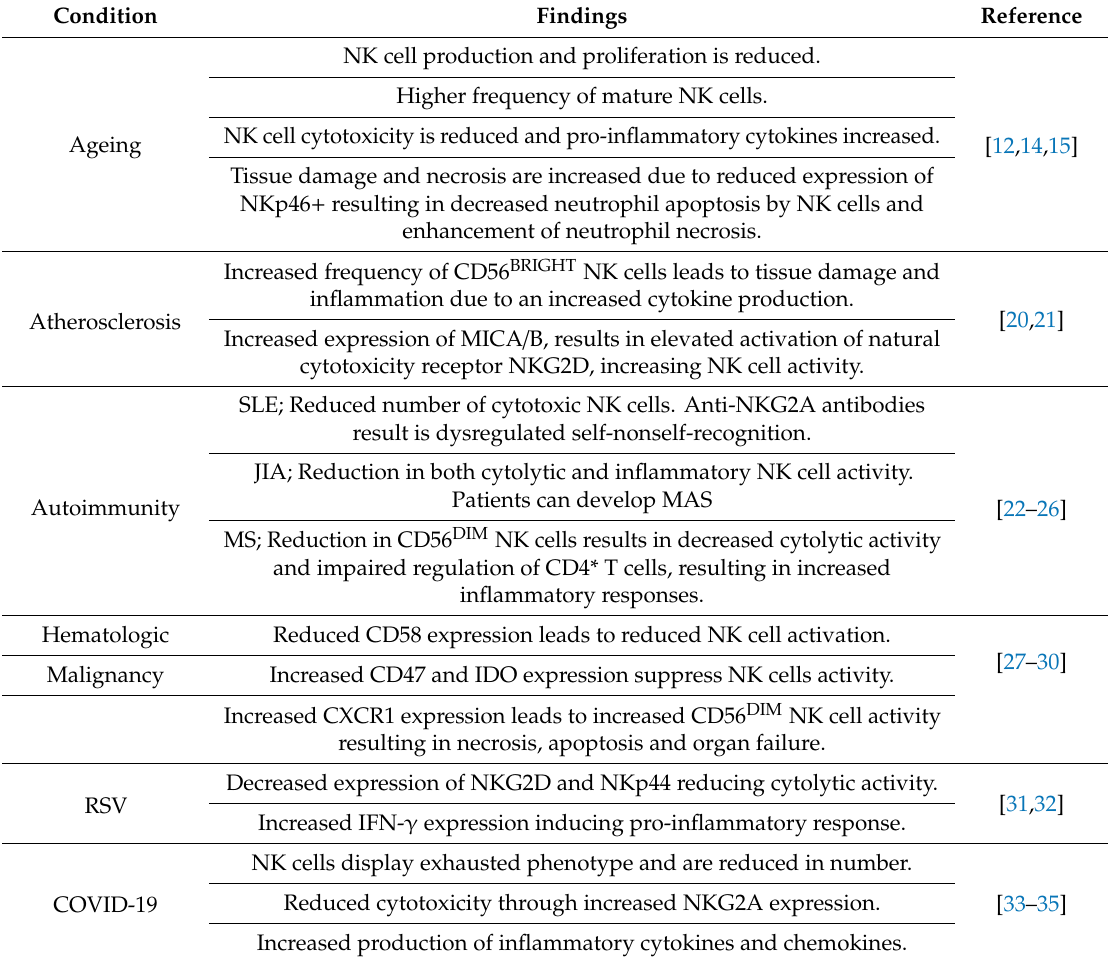
Table 1. Summary of published findings for NK cell dysregulation in disease and